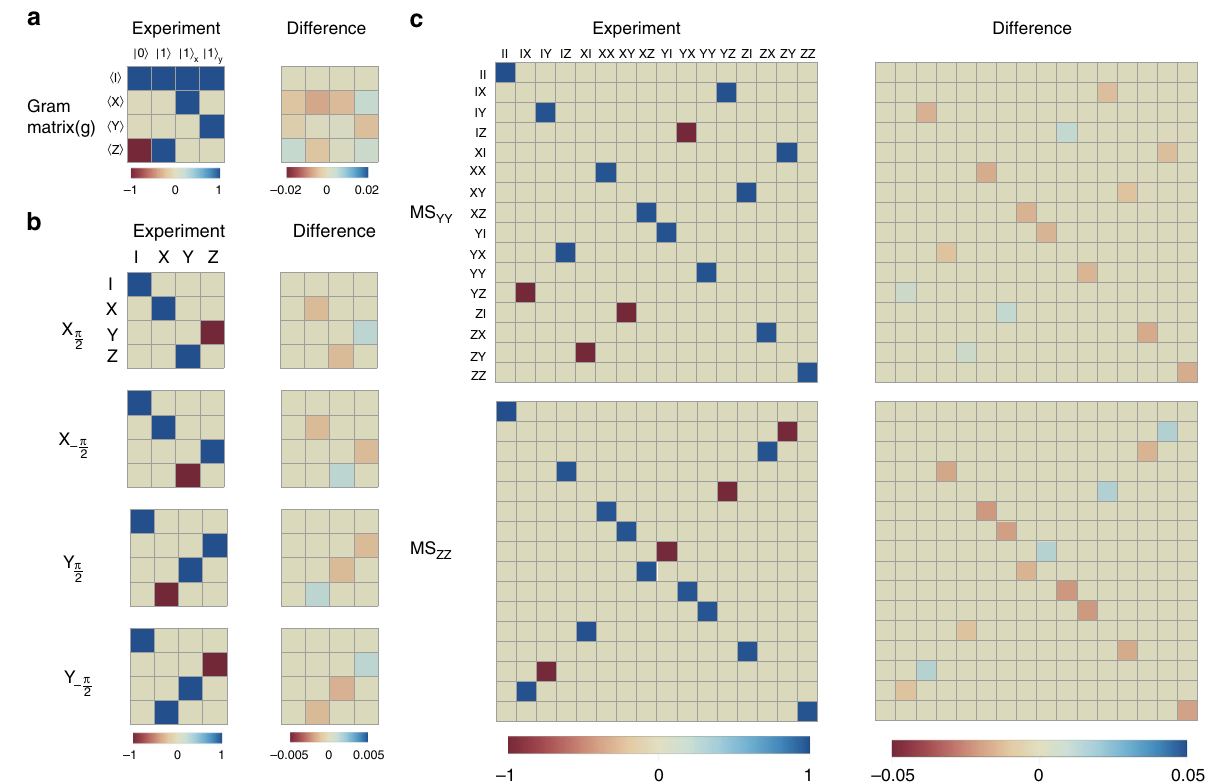
Fig. 2 Characterization of noisy quantum devices obtained by gate set tomography. a Gram matrix and b PTMs of single-qubit gates for the single-qubit case. The single-qubit experiments are implemented with a single trapped ion. The Gram matrix characterize the SPAM error, which is obtained by preparing states in S 1 and measuring expectation values of operators in P 1 . Here we show the PTMs of experimental gates X computational gates in randomized benchmarking, as examples (PTMs of other experimental gates are shown in Supplementary Fig. 1). c Pauli transfer matrices of the experimental gates MS YY and MS ZZ in the two-qubit case. It is worth noting that we calibrate the SPAM errors as proposed in ref. 31 and the PTMs of single-qubit gates on both qubits (not shown) are not noticeably different to those for the single-qubit case. In each sub fi gure, the left column shows the experimentally obtained matrices and the right column shows the difference between the experimental and the ideal matrices, i.e., R G being one of the quantum operations being characterized.